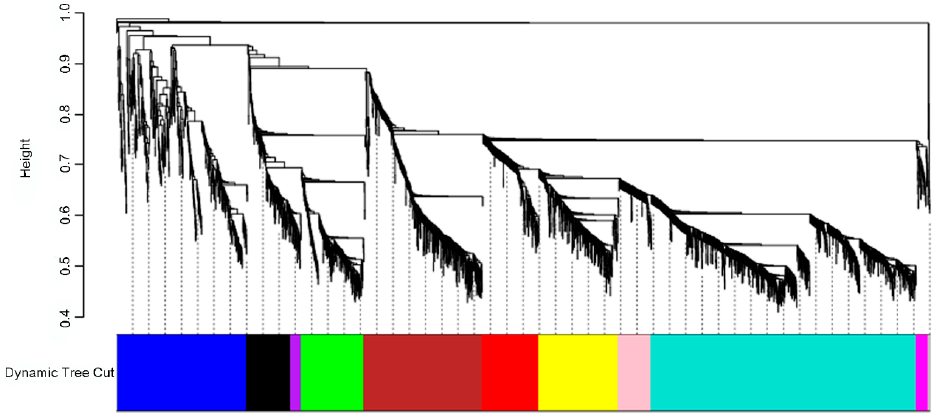
Figure 4. Identification of gene coexpression modules of all samples data (24 samples, 3000 genes) using average hierarchical linkage clustering; the y -axis denotes the coexpression distance and the x -axis corresponds to genes. Dynamic tree cutting was applied to identify modules by dividing the dendrogram at significant branch points. Modules are displayed with different colors in the horizontal bar.